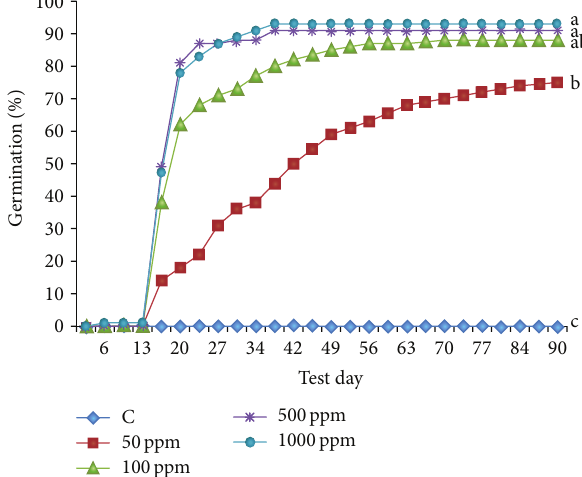
Figure 4: Germination curves of Gentiana lutea var. aurantiaca seeds using different doses of GA 3 (50, 100, 500, and 1000 ppm) and control